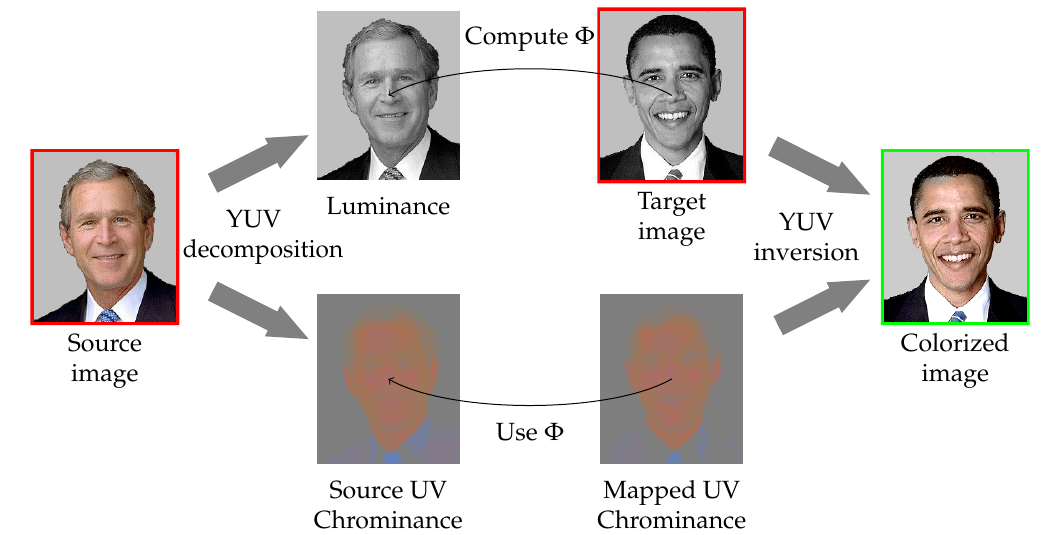
Figure 3. Overview of the color transfer. The mapping Φ is computed from Model (3) between the luminance channel of the source image and the target one. From this map, the chrominances of the source image are mapped. Finally, from these chrominances and the target image the colorization result is